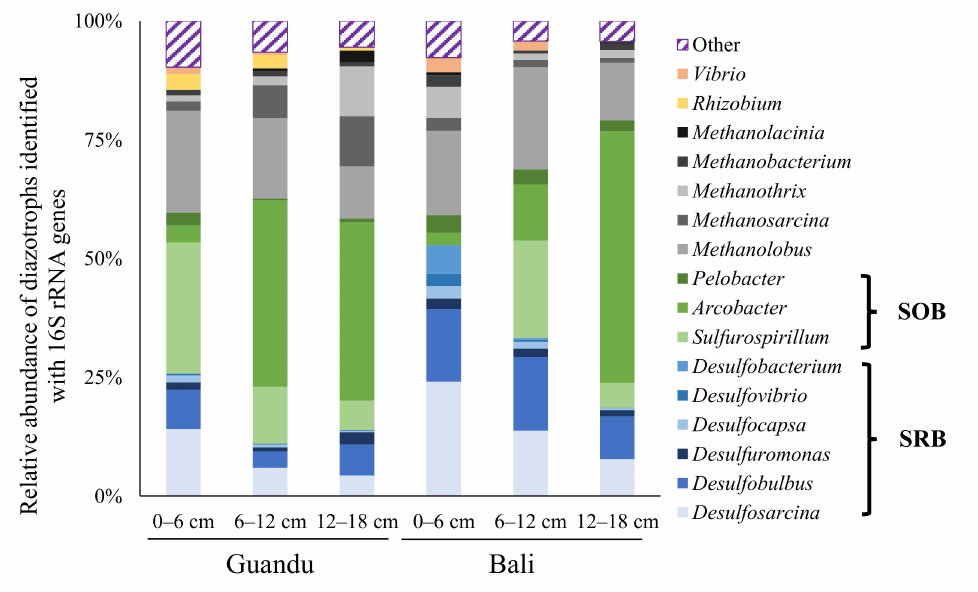
Figure 6. The relative abundances of diazotrophic genera identified using 16S rRNA genes in Guandu and Bali mangrove forest soils at the three soil depths. Sulfate-reducing bacteria (SRB) are in blue, sulfur and sulfide-oxidizing bacteria (SOB) are in green, and methane-related archaea are in grey. The diazotrophic genera selected were based on the Kyoto Encyclopedia of Genes and Genomes (KEGG) pathway